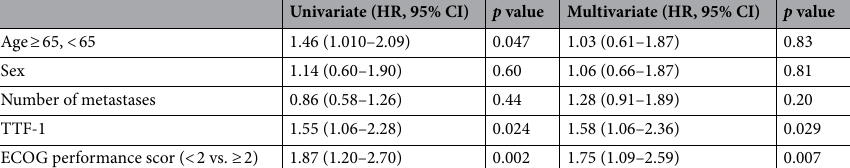
Table 2. Correlations between overall survival and clinicopathological factors. HR, hazard ratio; CI, confidence interval; TTF-1, thyroid transcription factor 1; ECOG, Eastern Cooperative Oncology